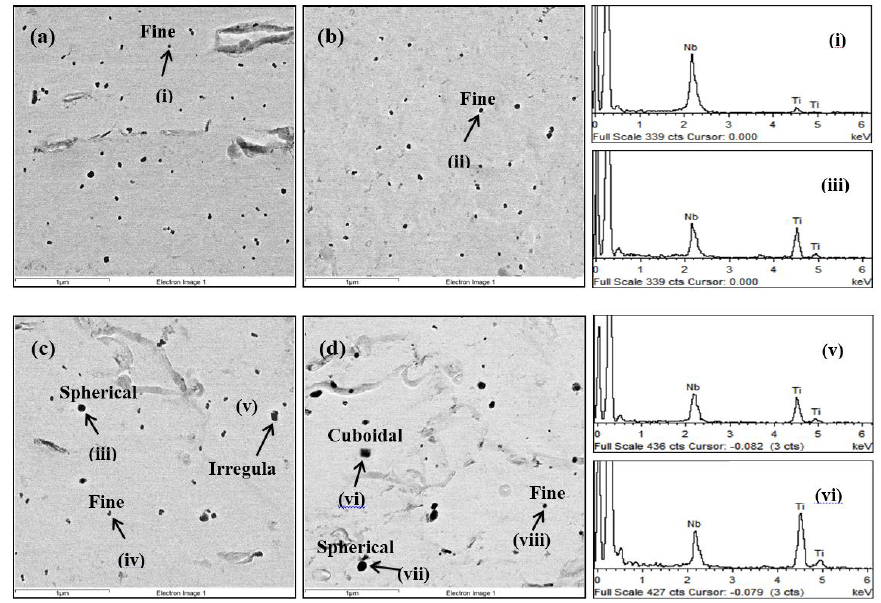
Figure 11. The TEM micrographs of the representative precipitates obtained from the specimens with different finish rolling temperatures: ( a ) 850 °C; ( b ) 830 °C; ( c ) 810 °C and ( d ) 790 °C.